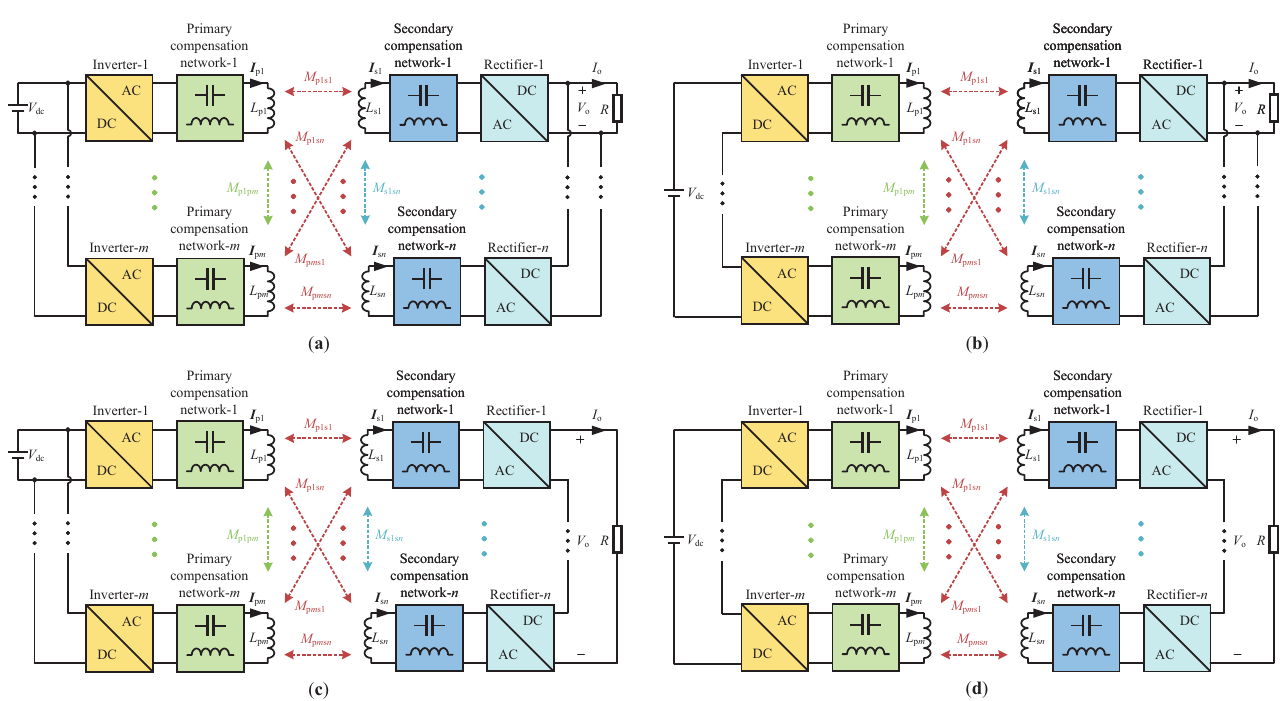
Figure 4. Diagram of multi-inverter/rectifier WPT modules based on ( a ) IPOP structure [83,84]. ( b ) ISOP structure [85,86]. ( c ) IPOS structure [31]. ( d ) ISOS